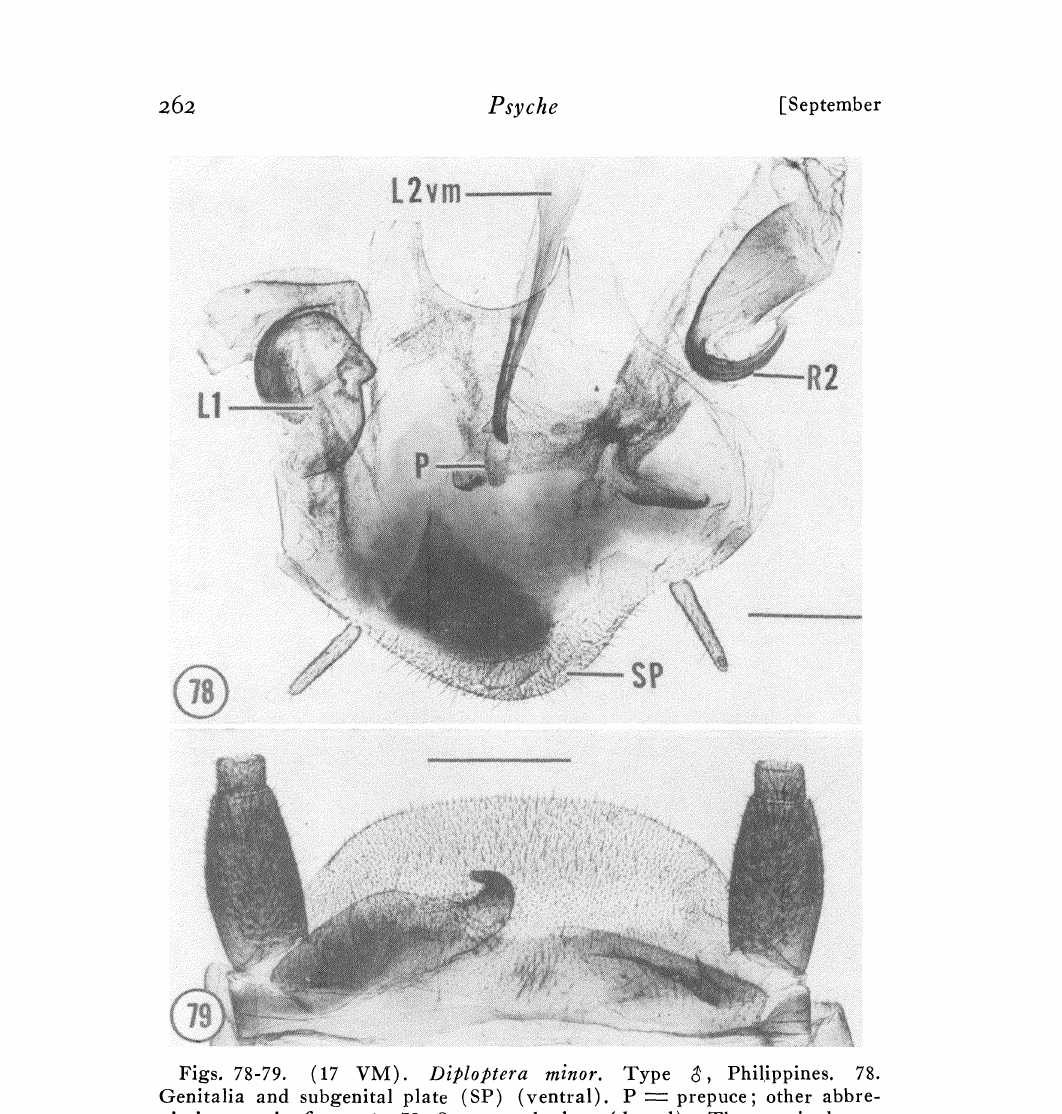
Figs, 78-79. (17 VM). Diploptera minor. Type Genitalia and subgenital plate (SP) (ventral). P prepuce; other abbre- viations as in figure 1. 79. Supra-anal plate (dorsal). The terminal seg- ments of the eerci were missing. The paraprocts are visible beneath the supra-anal plate in ,the cleared speeimen. (scale 0.5